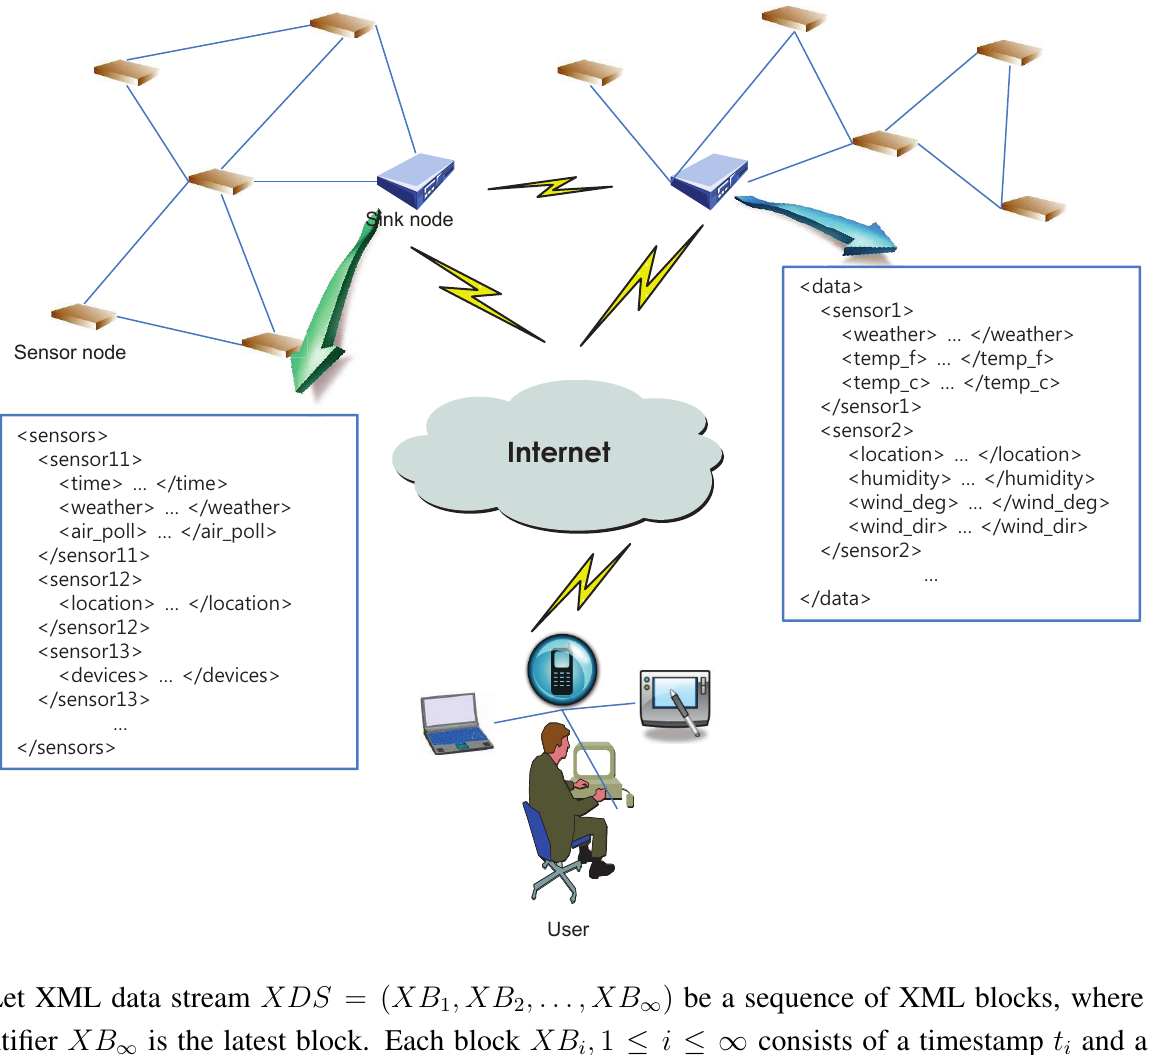
Figure 1. A system architecture for a WSN